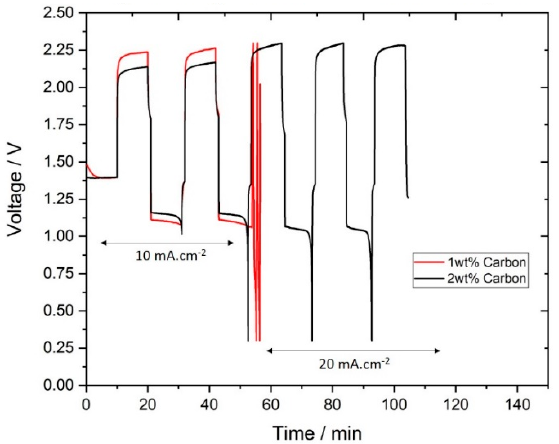
Figure 9. Charge-discharge curves of slurries without zinc particles.